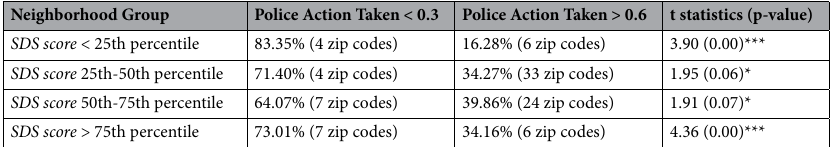
Table 4. The percentage of non-Hispanic White population for each sensitivity group by police action taken rate. Based on the citywide police action taken rate distribution, we use 0.3 and 0.6 as our thresholds, one standard deviation from the mean. The last column shows the results of t-tests for pairwise